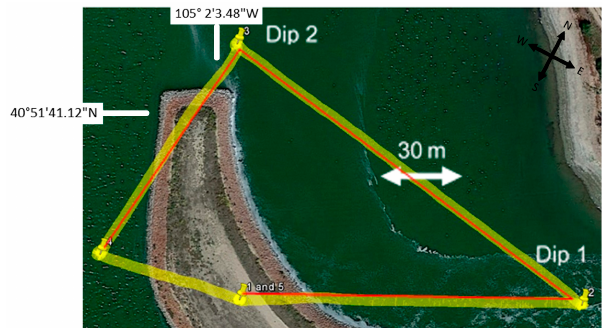
Figure 6. Flight path (actual in red and programmed in yellow) showing the three dip locations for the subsurface water temperature profiles at the Rawhide Energy Station.